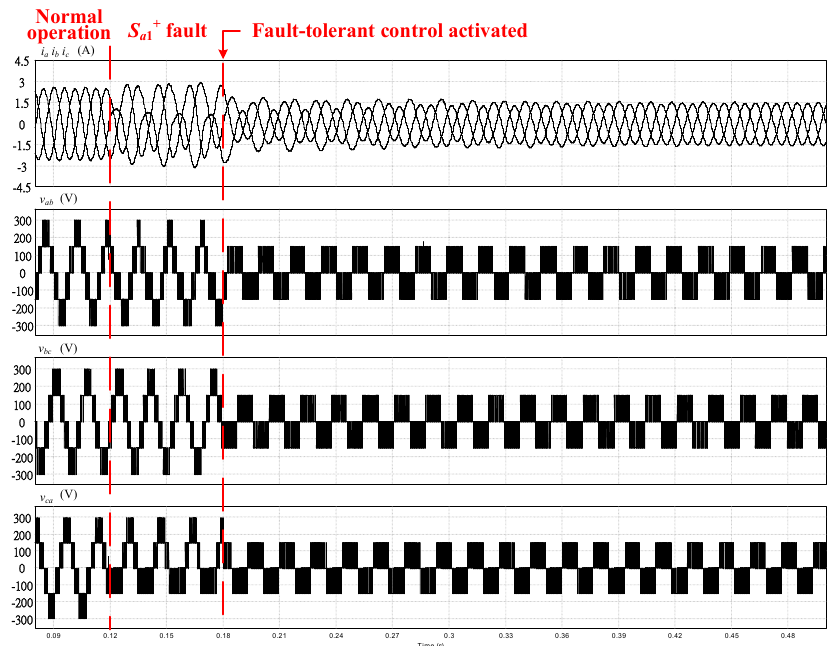
Figure 17. Waveforms of the output line voltage and line current of external switch S a 1 + with an open-circuit fault and tolerant control.